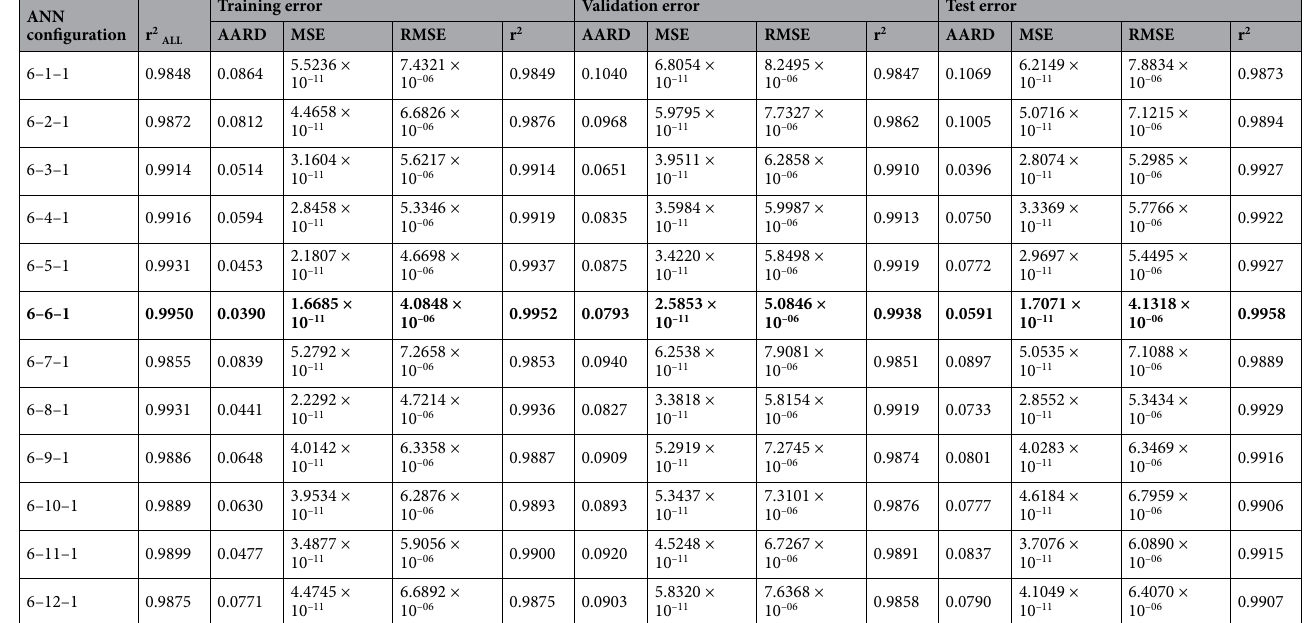
Table 6. Comparison of errors of several ANN configurations for estimation of fouling resistance. Significant values are given in